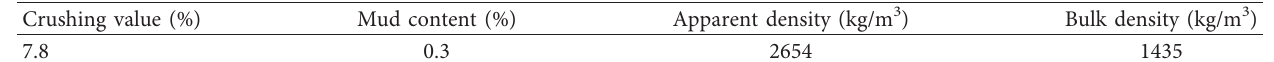
Table 5: Physical properties of coarse aggregate.